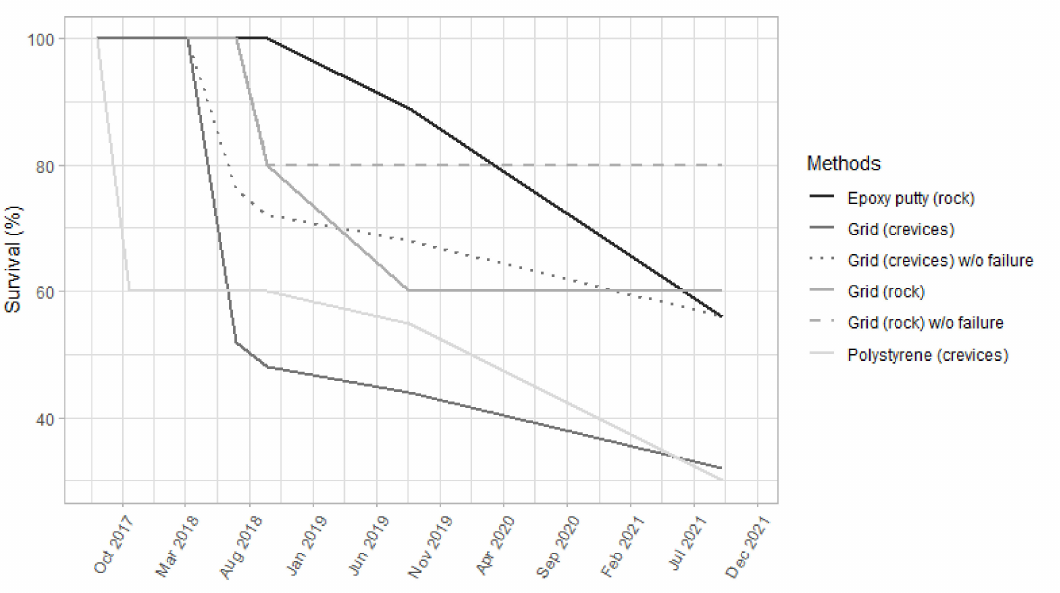
Figure 3. Survival (expressed in percentage) of C. rubrum transplants from the beginning of the experiments to November 2021 for each transplantation method at Gallinara Island. Dotted lines represent survival of transplants without taking the detachment of the grid into account. There is a total period of 4 years for transplants under crevices and 3 and a half years for transplants on rocks.